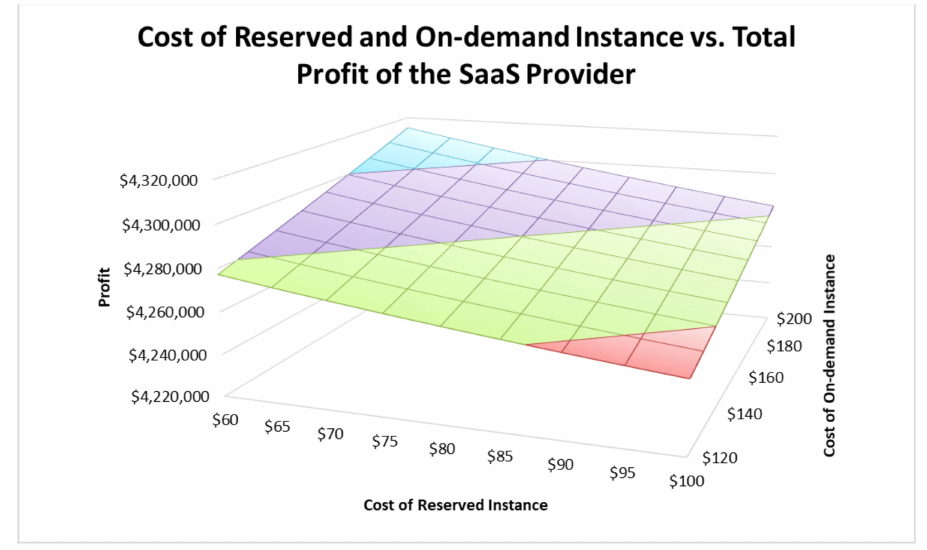
Figure 8. Cost of Reserved Instance and On-demand Instance vs. Total Profit of SaaS